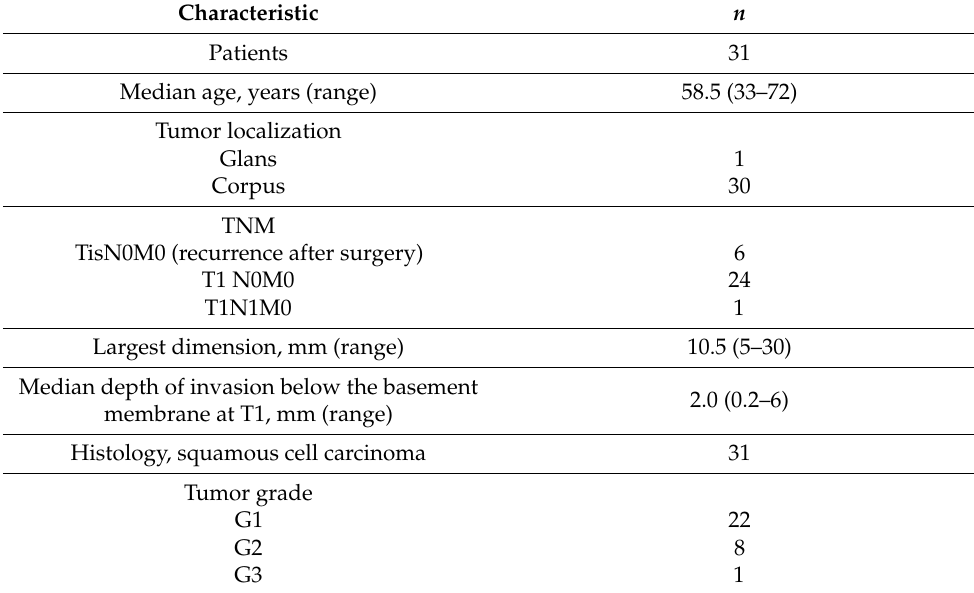
Table 1. Patient